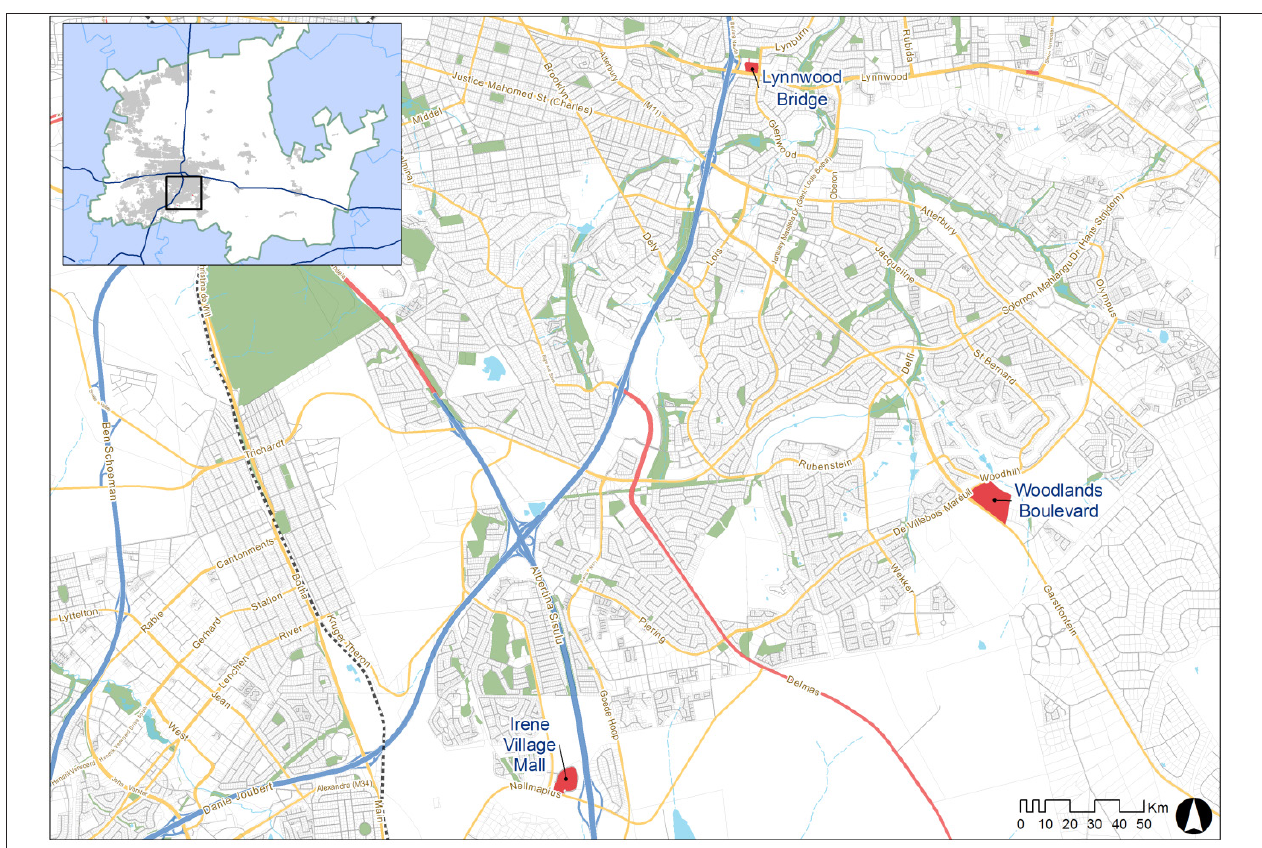
Figure 2: The location of the three shopping malls in the City of Tshwane Source: Produced by Darren Nel,